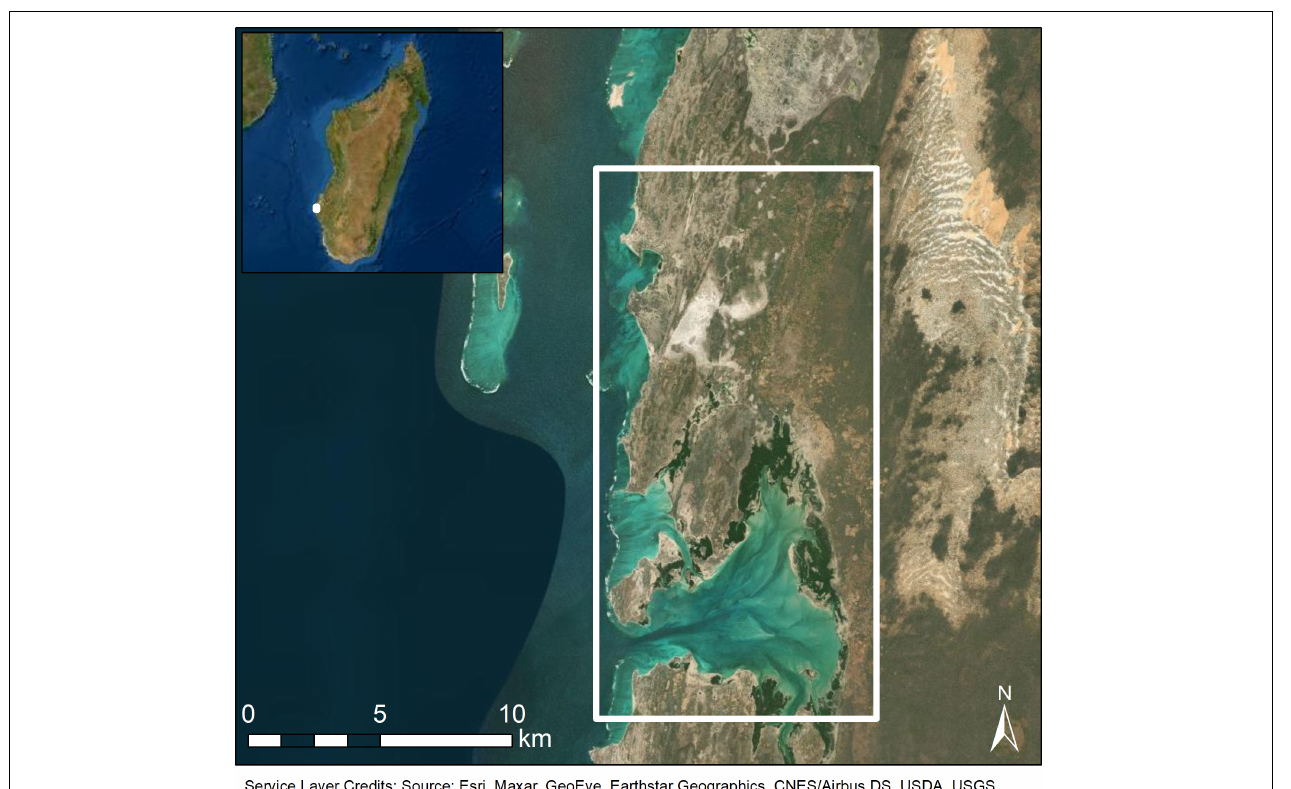
FIGURE 2 | Map of the study region (white